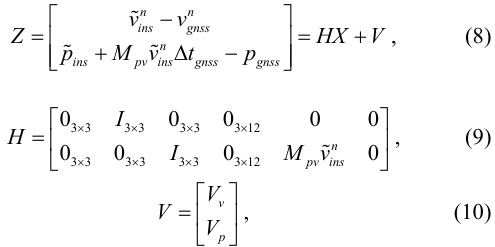
where M  state transition matrix of states  time constant of Markov process  Gaussian white noise The measurements of the EKF are GNSS position, GNSS velocity, NHC velocity and BLE positioning. When GNSS is available, the measurement equations of EKF could be written as Equation (8-10), where GNSS velocity and position are used to integrate with